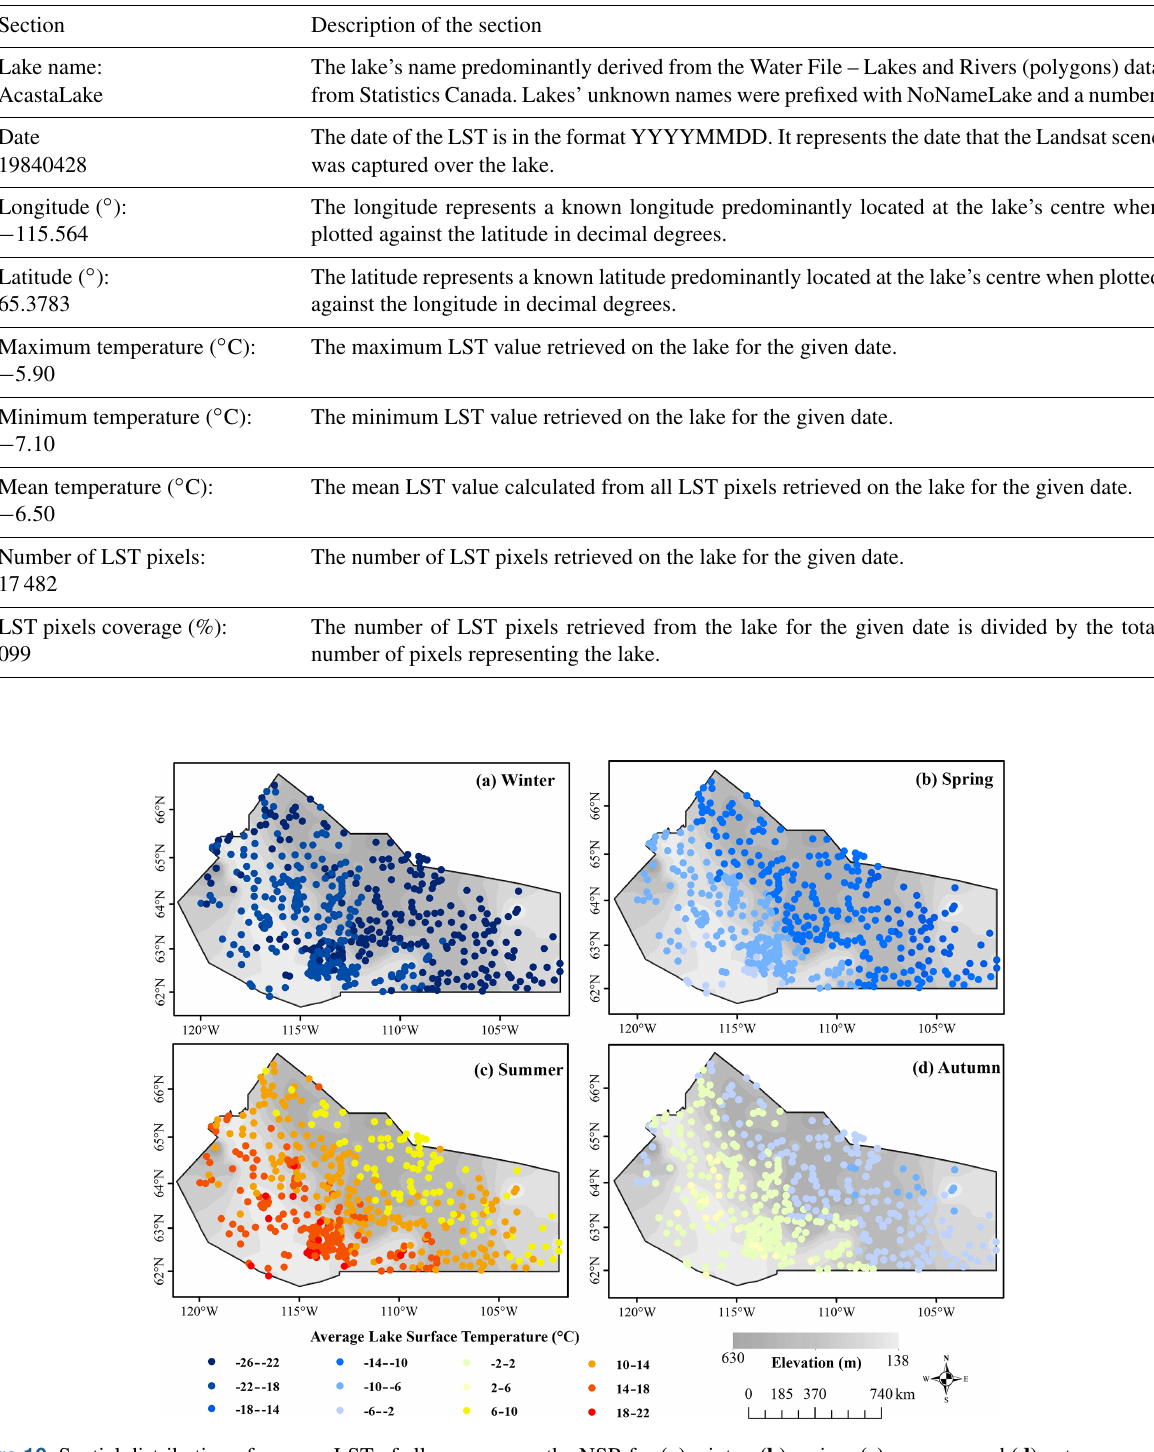
Earth Syst. Sci. Data, 15, 1329–1355,